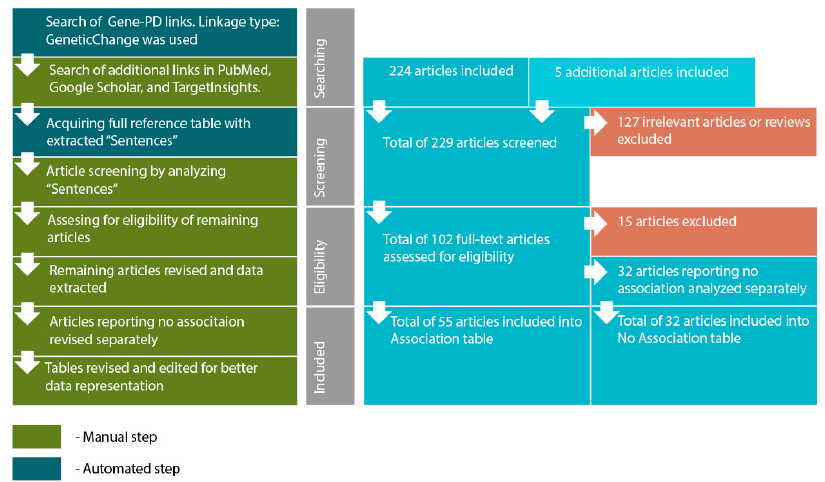
Figure 1. Workflow used in the current review and number of articles included or excluded on each step.